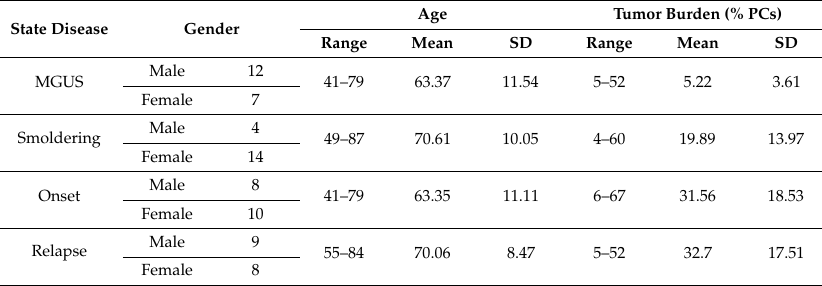
Table 1. Clinical characteristics of the studied MM